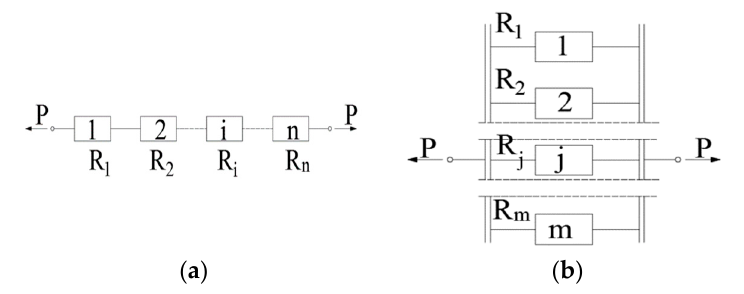
Figure 1. The layout of a system: ( a ) serial and ( b ) parallel.